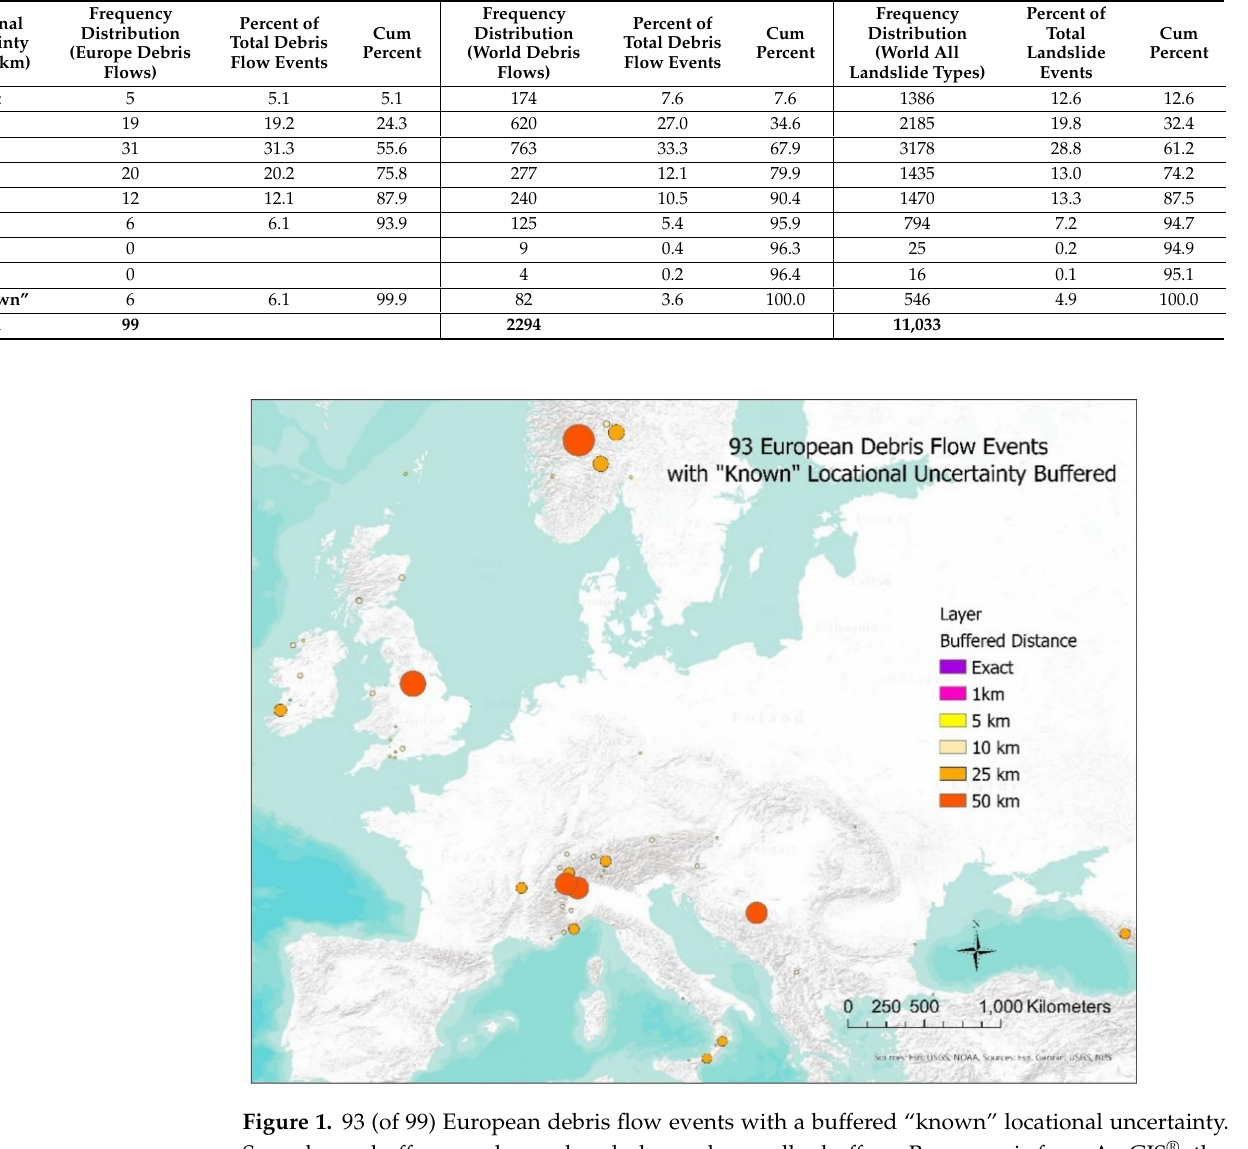
Table 1. Locational uncertainty frequency distribution of global inventory: Europe debris flows (left), world debris flows (center), and world–all landslide types (right). The Europe debris flows are used for this study.